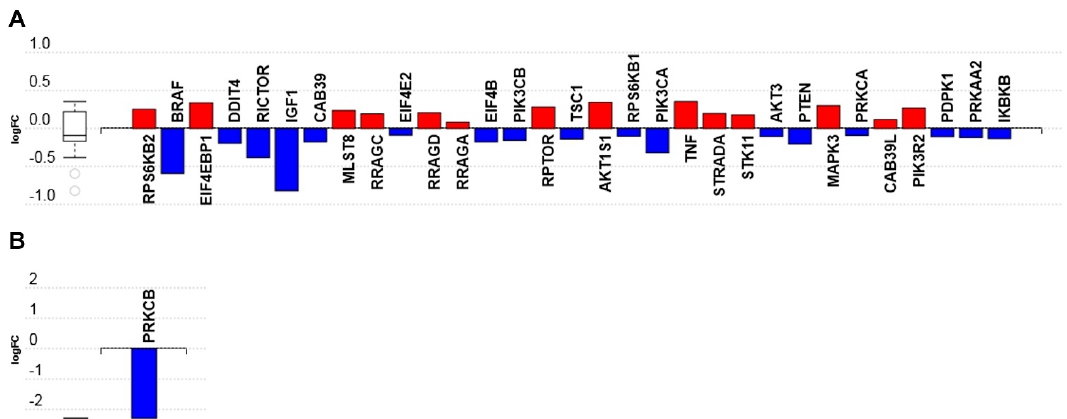
Figure 6. The mTOR signaling pathway mRNA transcripts regulated in response to C16 ceramide-enriched lipoproteins in human podocytes. Podocytes were induced with C 16 ceramide-enriched or native lipoproteins and RNA-seq assay was performed as described in Figure 3 legend. ( A ) Cells induced with ceramide-enriched or native LDL; ( B ) cells induced with ceramide-enriched or native HDL2. Figure generated by iPathwayGuide (Advaita Bioinformatics) software; log FC, logarithm of fold change of gene expression. Box and whisker plot: the ends of the box are the upper and lower quartiles, box spans the interquartile range. Horizontal line inside the box denotes the median and the whiskers are the two lines outside the box extend to the highest and lowest observations.